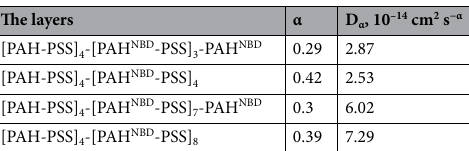
Table 1. Calculated values of α and Dα of the quencher in the layers.